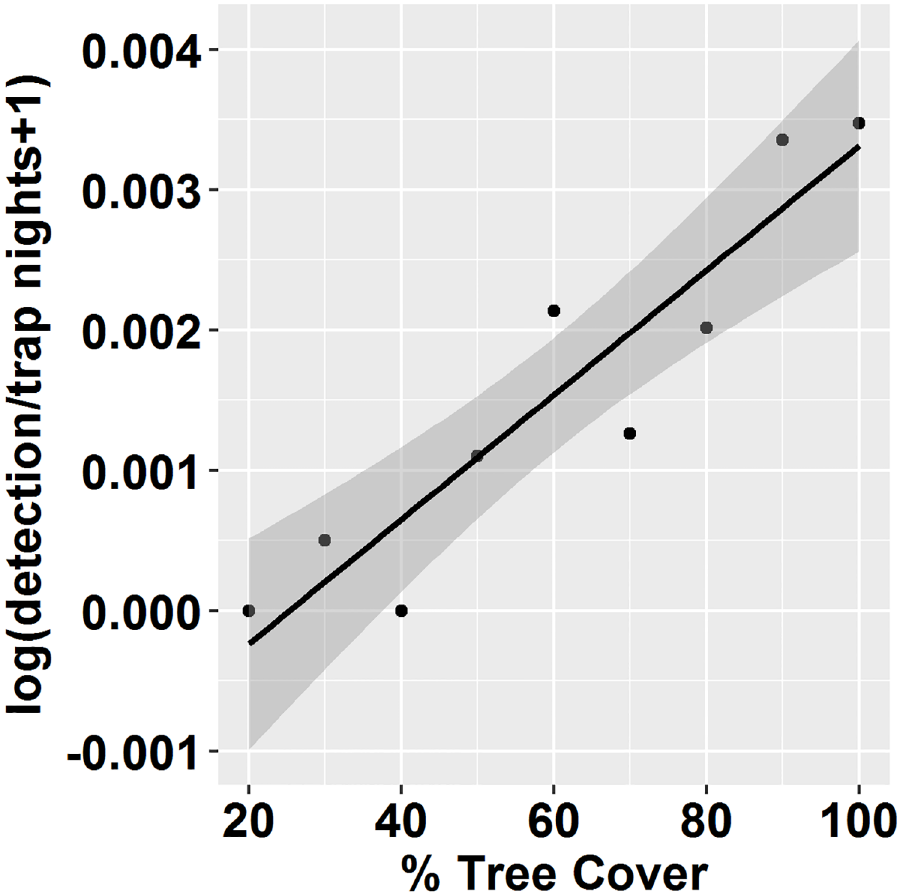
Fig 2. The log-linear relationship between sun bear detection rates at cameratraps and % tree cover. We pooleddata from camera traps active between2000–2015 into % tree cover categories( < 20%,21–30, 31–40, ... 91–100),and calculatedthe detectionrate of sun bears within each category by dividingthe total numbercameras that detected a sun bear at least once within a trappingperiodby the total number of traps nights cameras were active. We log-transformed detection rates and increasedby 1 to avoid infinitevalues. Camera traps were active within all levels of tree cover, and were more active in areas of high tree cover (S2 Fig). Tree cover (0–100%)at camera traps, taken from rasters of tree cover closest in time to when cameras were active, were averaged over a 6-km 2 area aroundcamera traps to represent tree cover at the scale of a core sun bear range. In a simple linear regression,sun bear detections(log) rates were positivelyrelated with % tree cover (ln([Y]/Trap Nights+1)= -8.16 + 0.03 * TreeCover, R 2 =